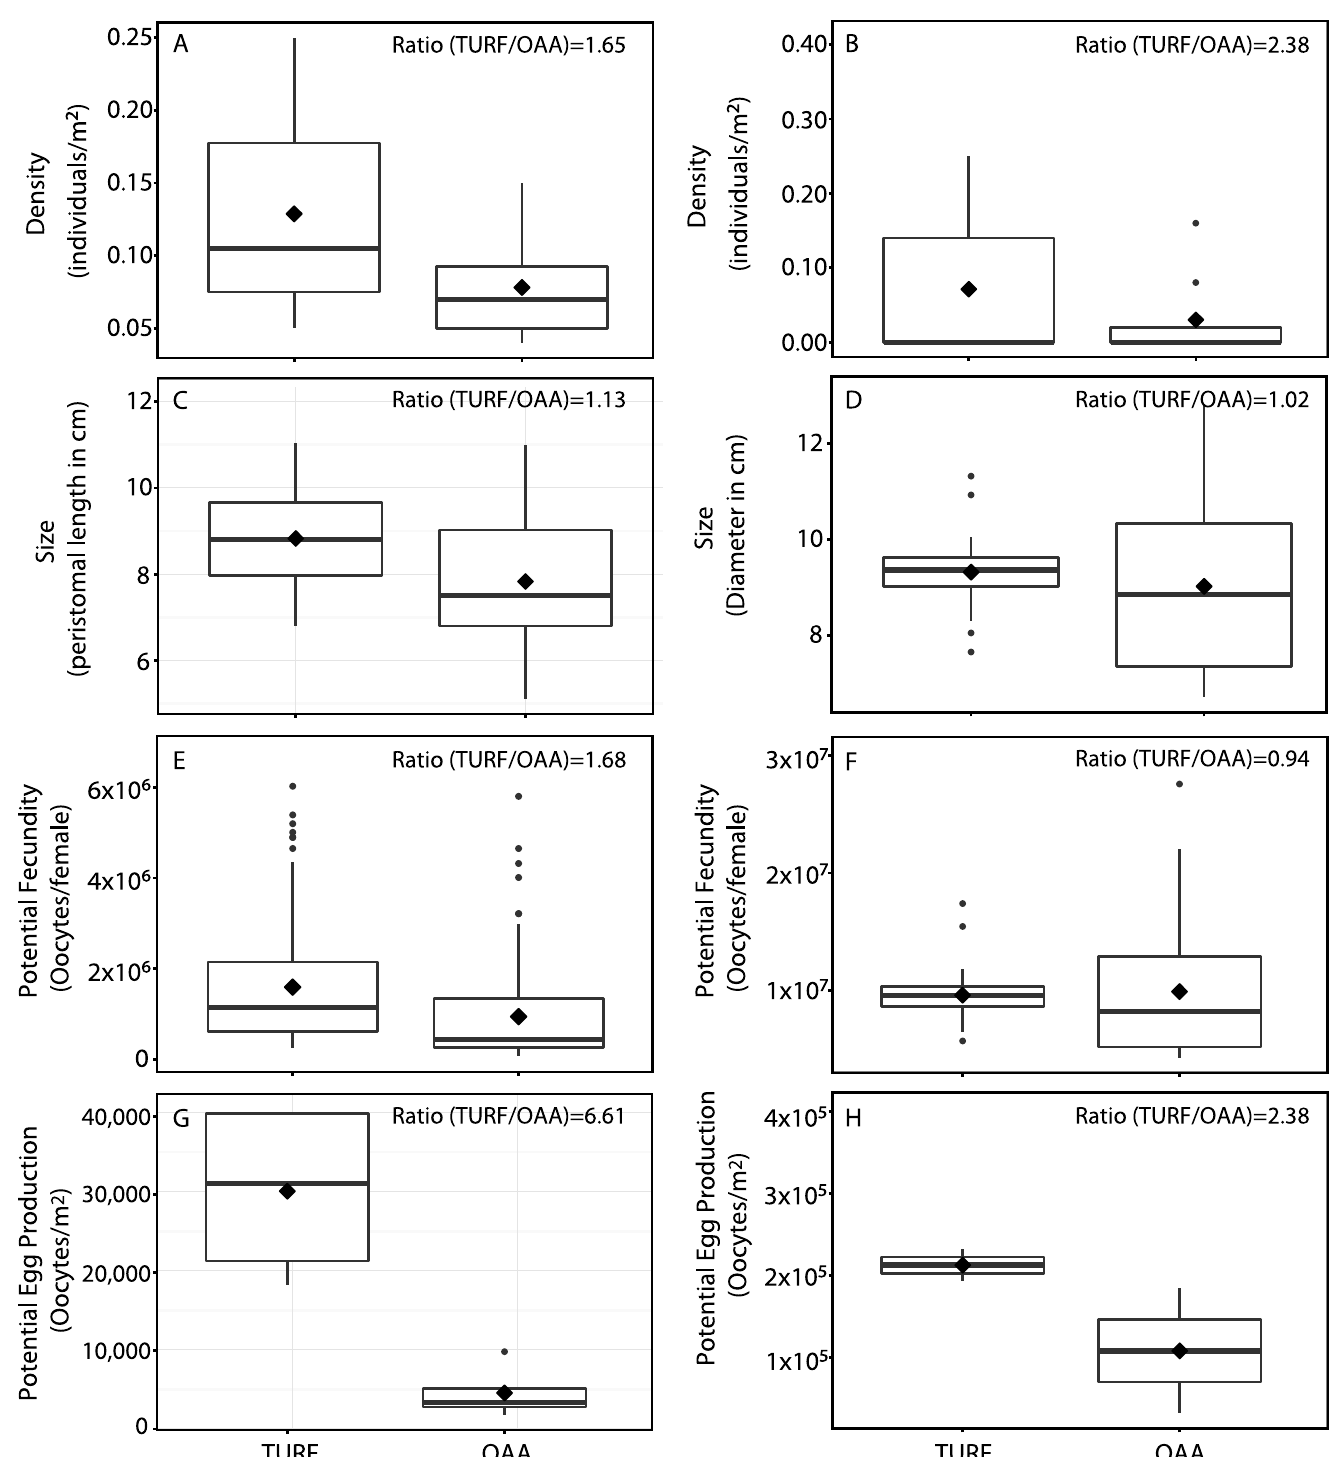
Fig 2. Biological variables between fishing regimes. Box plots showingdensity, size, potentialfecundity and potential egg productionin areas under different fishing regimes: TerritorialUse Rights for Fisheries (TURF) and Open Access Areas (OAAs; not limiting the entry of fishers). The number in the right corner in each plot indicatesthe ratio betweenfishing regimes(TURF/OAA) for each variable.Black diamonds’ indicatemean: (A) Fissurella latimarginata density; (B) Loxechinus albus density; (C) F . latimarginata size; (D) L . albus size; (E) F . latimarginata potential fecundity; (F) L . albus potential fecundity; (G) F . latimarginata potential egg production;and (H) L . albus potential egg production.